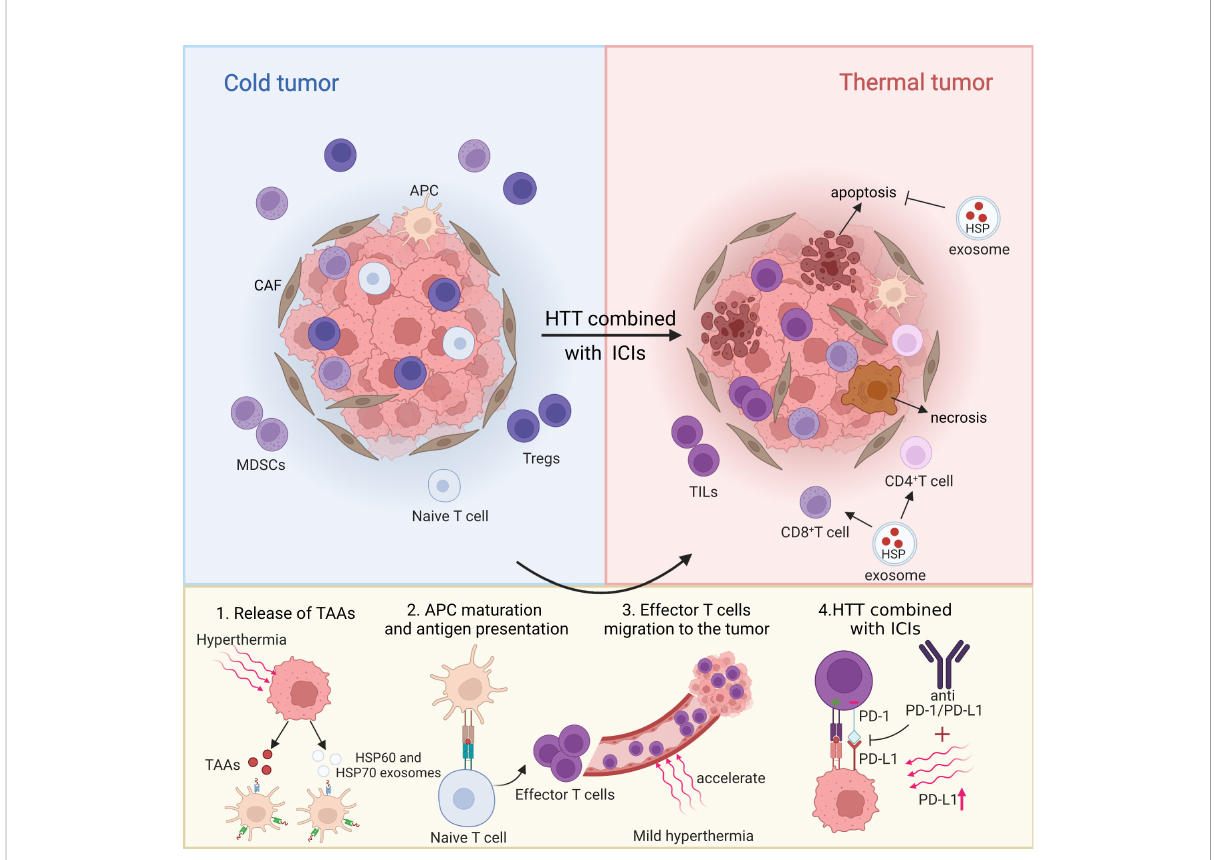
FIGURE 1 Partial mechanism diagram of hyperthermia combined with ICIs on tumor microenvironment. Created with